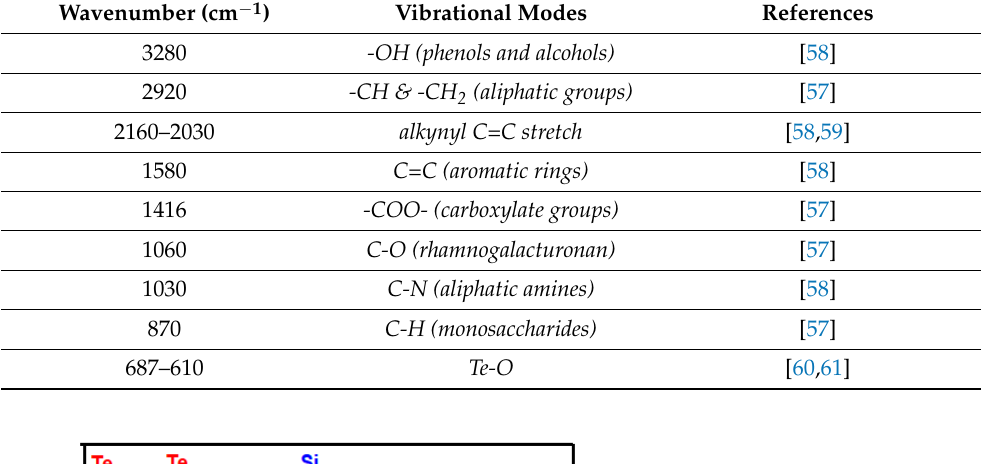
Table 1. FT-IR main features of aloe vera-mediated tellurium nanoparticles (AV-TeNPs).